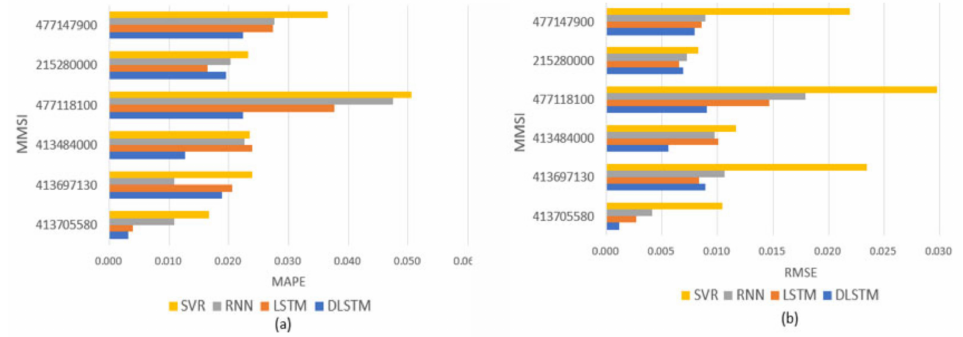
Figure 12. Predicting errors in vessel trajectories. ( a ) MAPE; ( b )